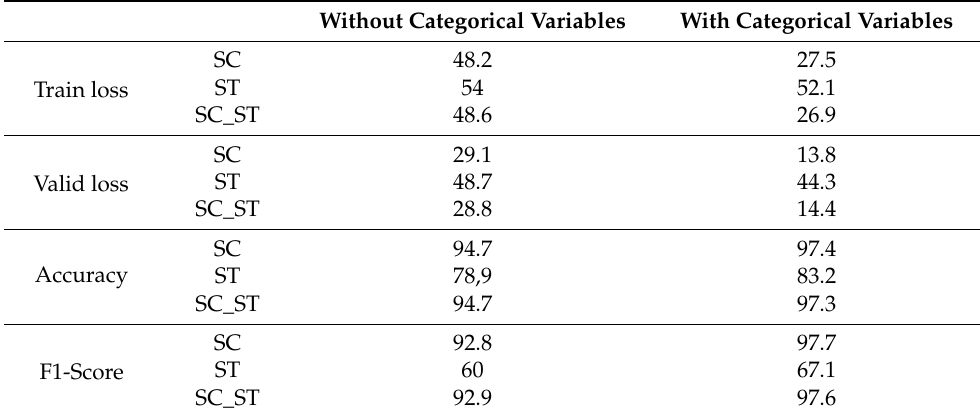
Table 2. Performance of the deep learning model. Without Categorical Variables With Categorical